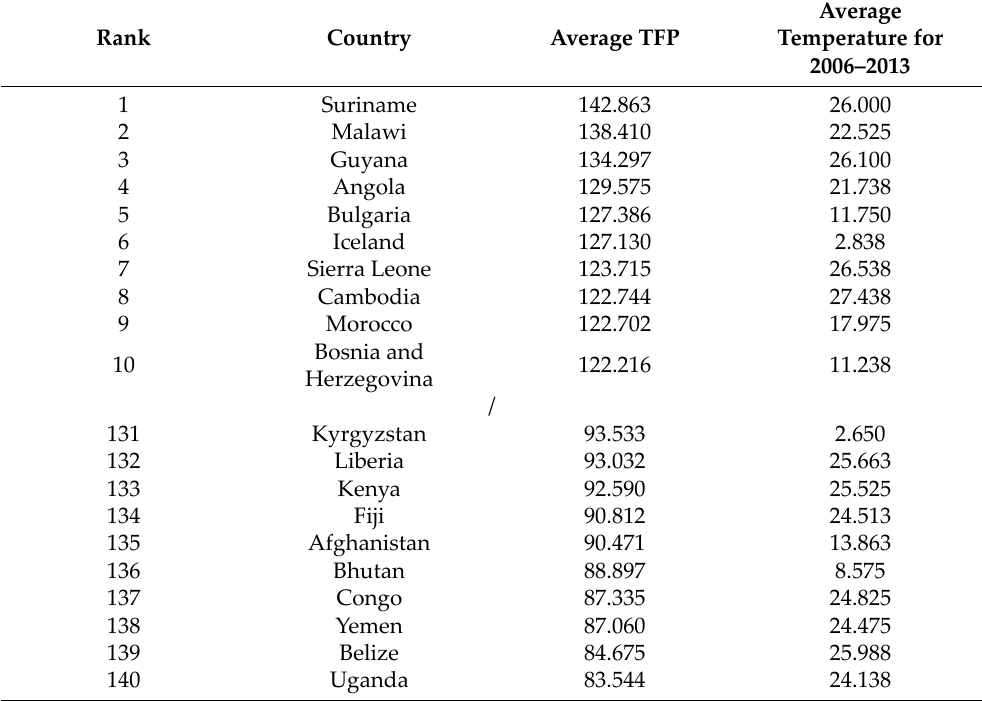
Table 3. Top and bottom 10 countries by TFP for